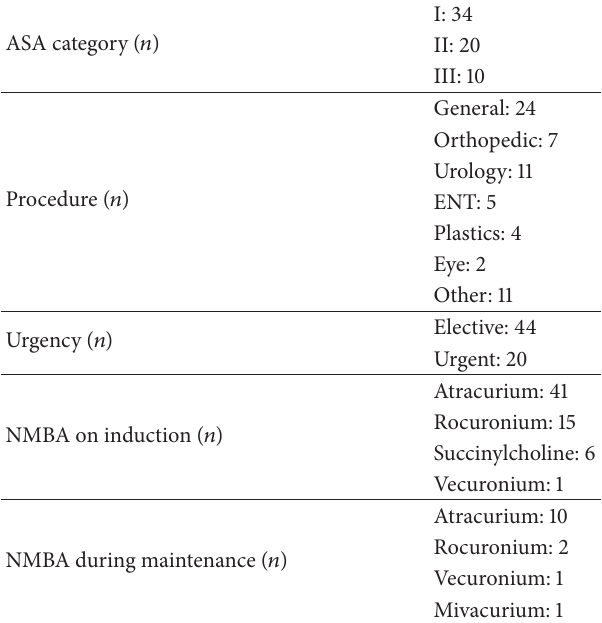
Table 1: Patient characteristics (ASA: American Society of Anesthe- siology, NMBA: neuromuscular blocking agent); total 𝑛 =